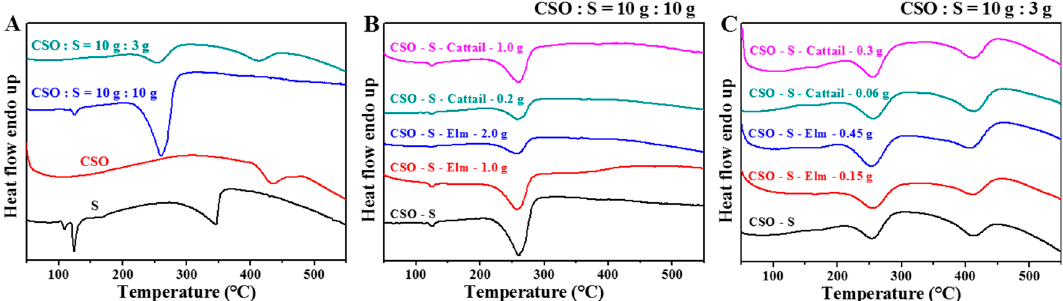
Figure 5. DSC thermograms of sulfur, cottonseed oil (CSO) and bio-based polysulfide composites. ( A ) S, CSO, 10.0 g CSO + 10.0 g S, 10.0 g CSO + 3.0 g S, ( B ) 10.0 g CSO + 10.0 g S + different fillers, ( C ) 10.0 g CSO + 3.0 g S + different fillers.